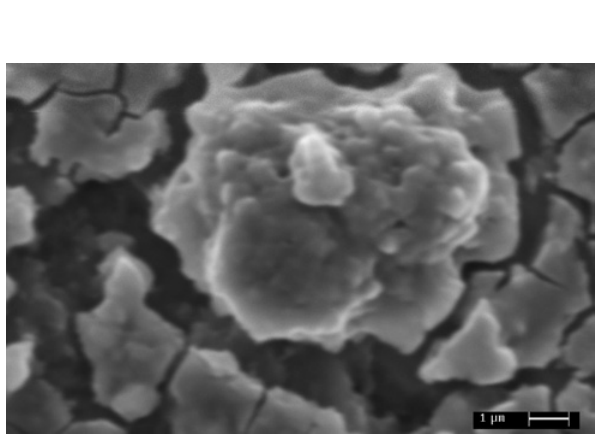
Figure 1: EDS spectra of the powder obtained at (A) pH 6.5 and (B) pH 8.